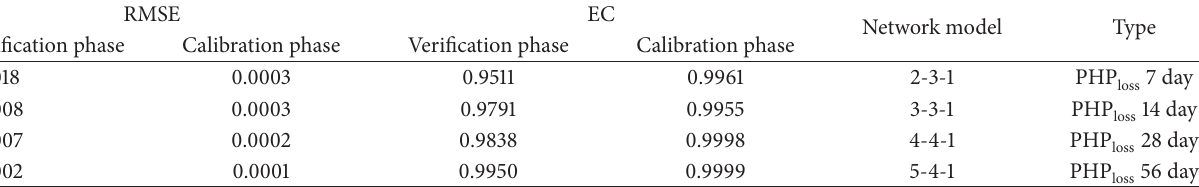
Table 4: The results of PHP modeling method based on artificial neural networks. loss